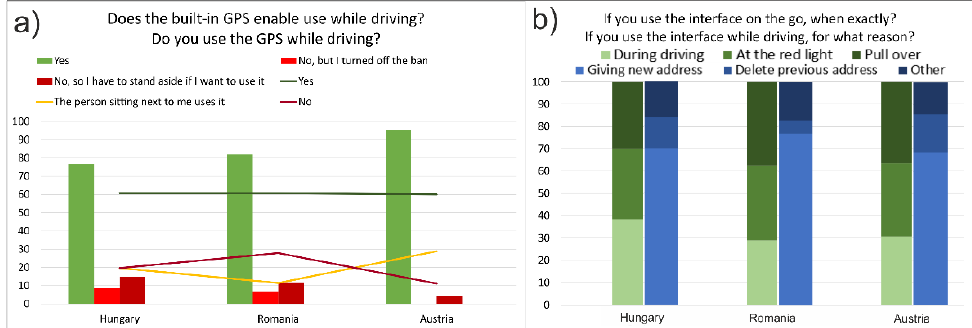
Figure 9. Answers about ( a ) GPS usage while driving and ( b ) the reasons for the interface usage.